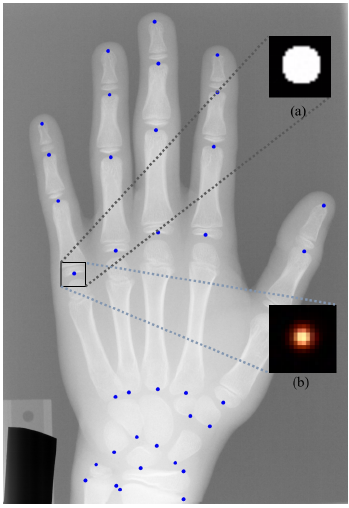
Figure 3. The segmentation mask and ground truth heatmap: ( a ) the segmentation mask, which is a local neighborhood patch P i centered at landmark g i with radius r = 1 pixels; ( b ) the groud truth k k heatmap, which is a Gaussian distribution centered at landmark g i with the σ = k